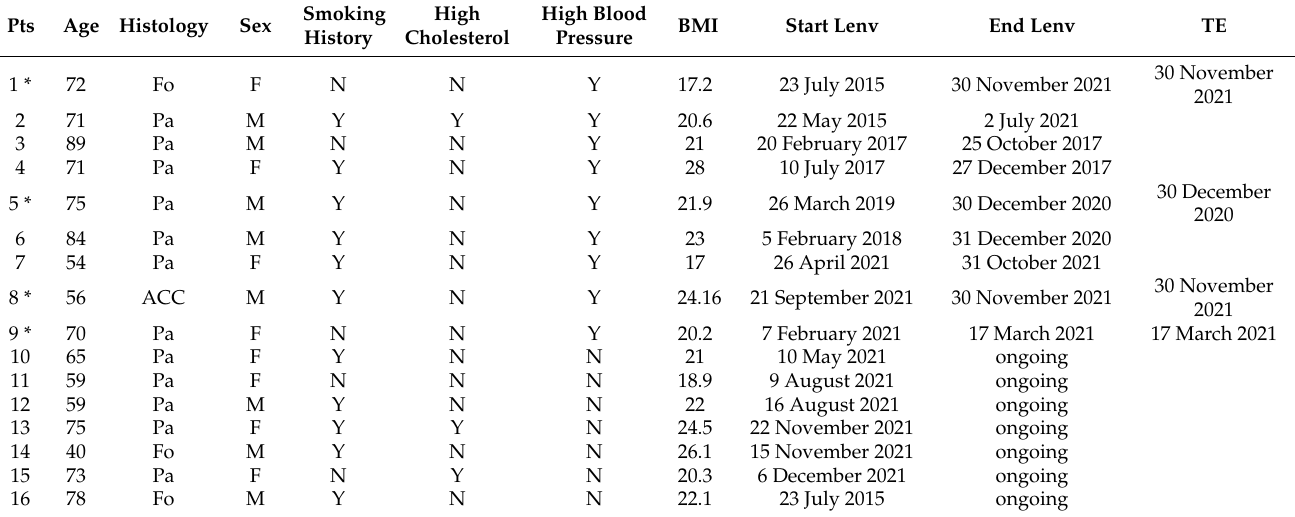
Table 2. Characteristics of patients who suffered from cerebrovascular events.